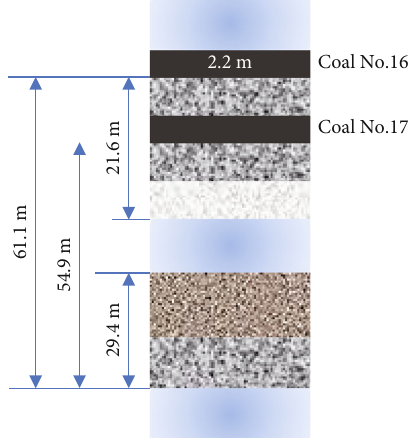
Figure 2: Location relationship between coal seam and